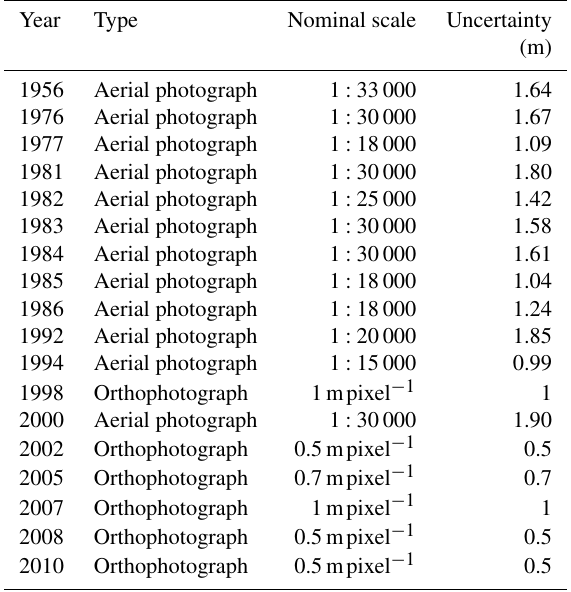
Table 2. Photographs available for the study